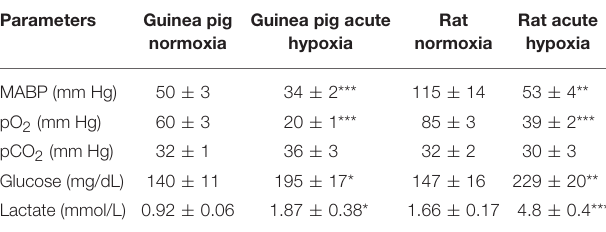
TABLE 1 | Cardiorespiratory and metabolic